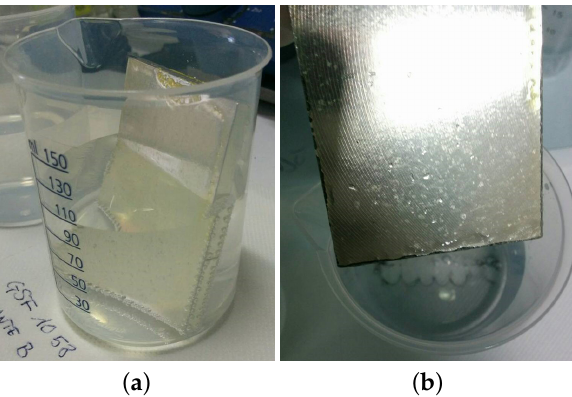
Figure 6. Dipping test on AM60 alloy with lacquer GSF coating during ( a ) and after ( b ) the test. When testing the PA11 samples, the formation of bubbles was not detected and there were no visible signs of corrosion neither in the white nor in the transparent sample. The ICP-OES measurements did not reveal migration of Mg or other metals from the sample in the simulant B used in the contact. The specific migration for each element calculated from these tests is available in Table S2 in the Supplementary